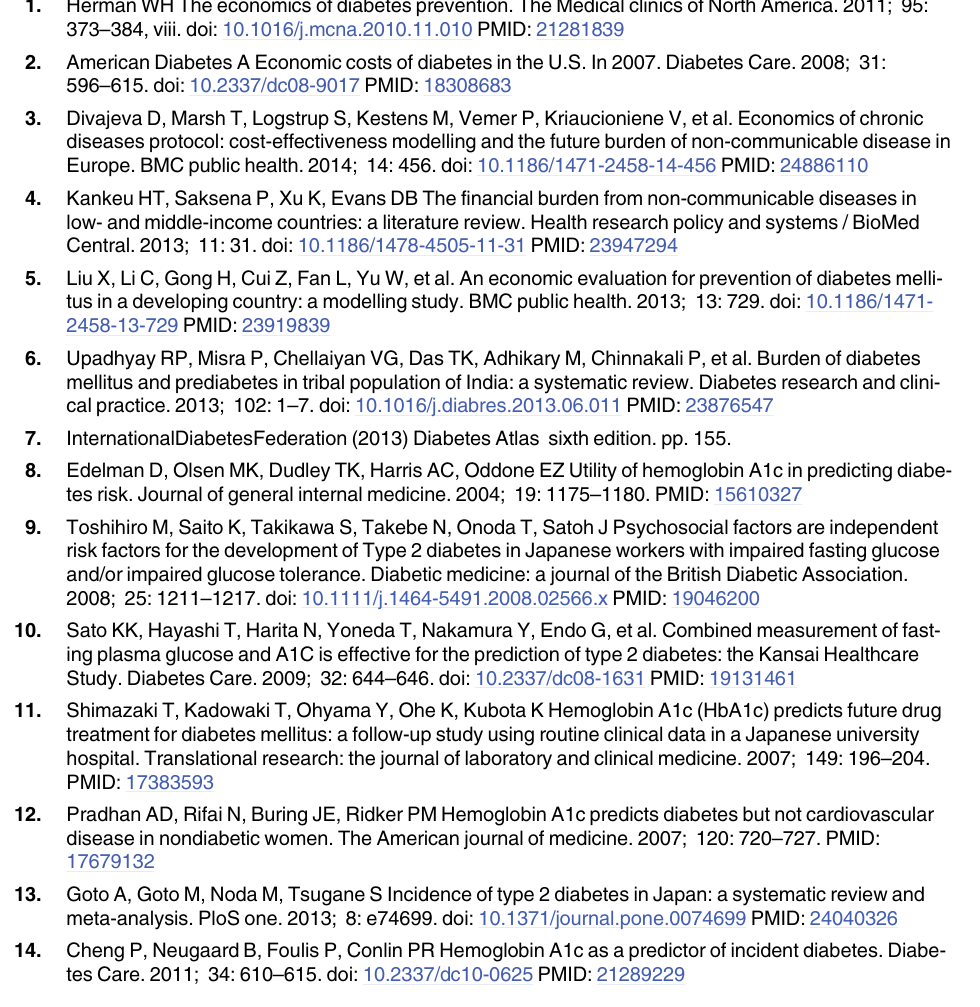
levels in the follow-up and lost to follow-up 1c